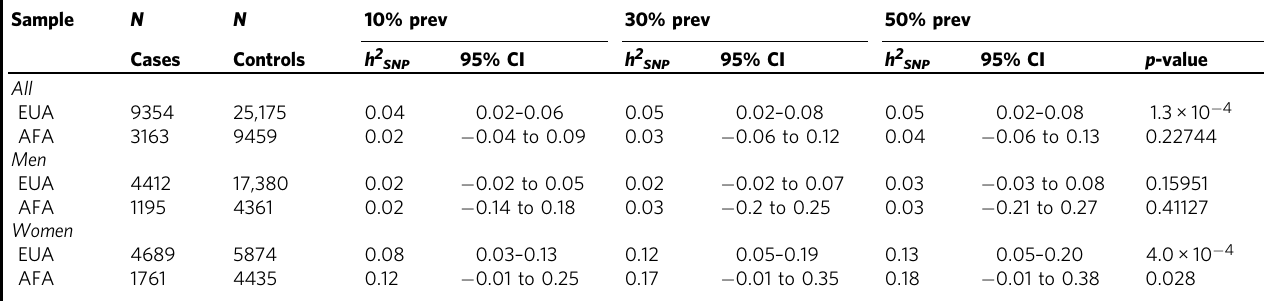
Table 2 Comparison of heritability between European (EUA) and African ancestry (AFA) studies